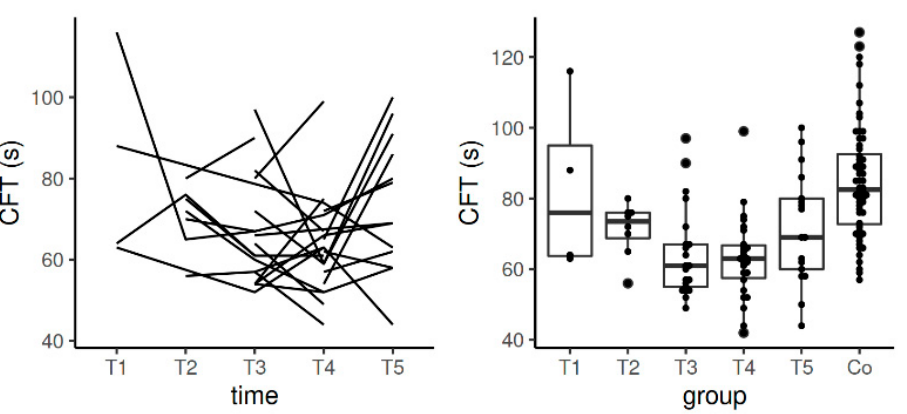
Figure 3. Spaghetti plot of the data from the longitudinal study (left), and swarmplot with boxplot of the same data together with the data from the control group (right)—the results of CFT in EX-